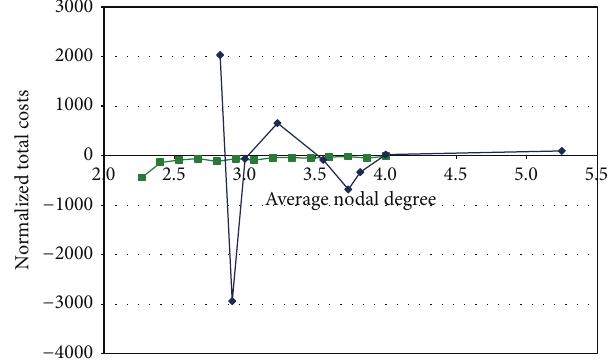
Figure 17: Slope of path restoration JCA normalized total capacity